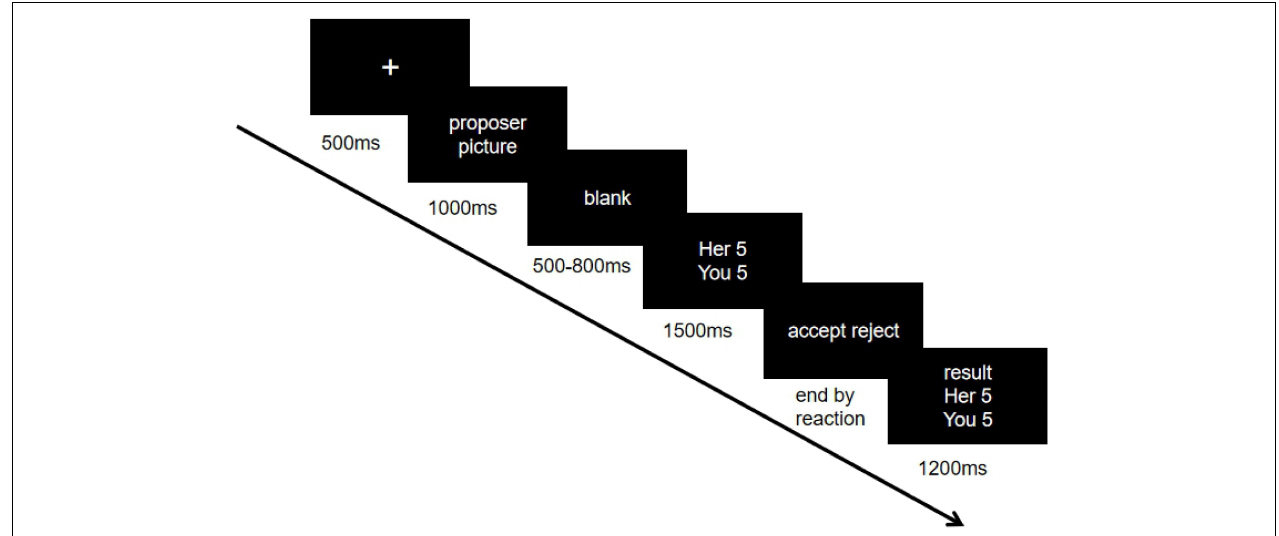
FIGURE 1 | An example of the ultimatum game (UG). First, a cross will appear in the center of the screen for 500 ms, after that the picture of the gaming object will appear on the screen for 1,000 ms, after a random empty screen from 800 to 1,500 ms the allocation scheme proposed by the proposer will be presented for 1,500 ms, after that the responder will see the interface of the response and choose to accept or reject it to enter the next process, and finally the result of this round will be presented for 1,200